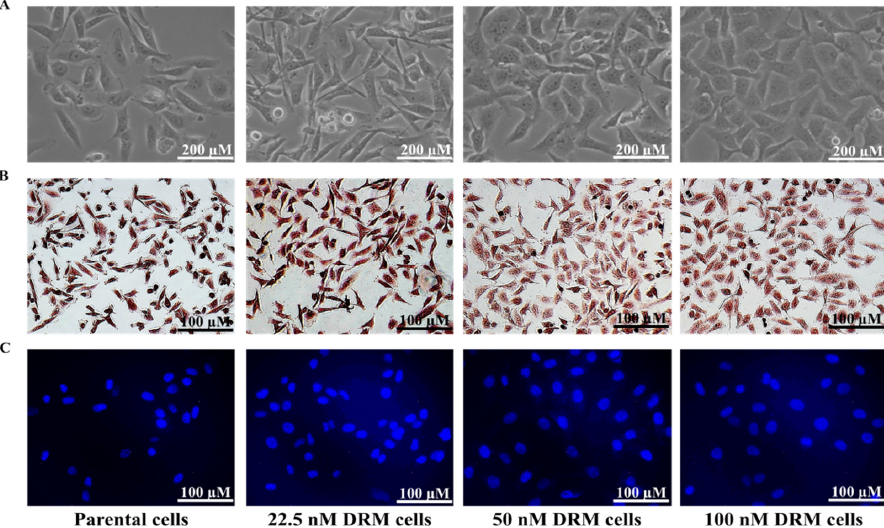
Figure 2. Morphological analysis of DRM cells ( A ) Morphological analysis performed under a light mi- croscope 48 h after cells were seeded. DRM cells showed an increase in cell size and cell-to-cell com- munication. The cells changed from spindle-like structures to cobblestone-like giant cells as acquiring resistance to doxorubicin (Magnification, ×200; scale bar, 200 μm) ( B ) Whole-cell morphology analyzed with Mayer’s staining. DRM cells showed morphological changes with acquiring resistance to higher concentrations of doxorubicin. (Magnification, ×100; scale bar, 100 μm) ( C ) DAPI staining showing the nuclear morphology of DRM cells. DRM cells showed an increase in nuclear size with advance- ment in doxorubicin resistance. Results were confirmed by three independent experiments. (Mag- nification, ×100; scale bar, 100 μm). DRM: Doxorubicin-resistant MDA-MB-231.